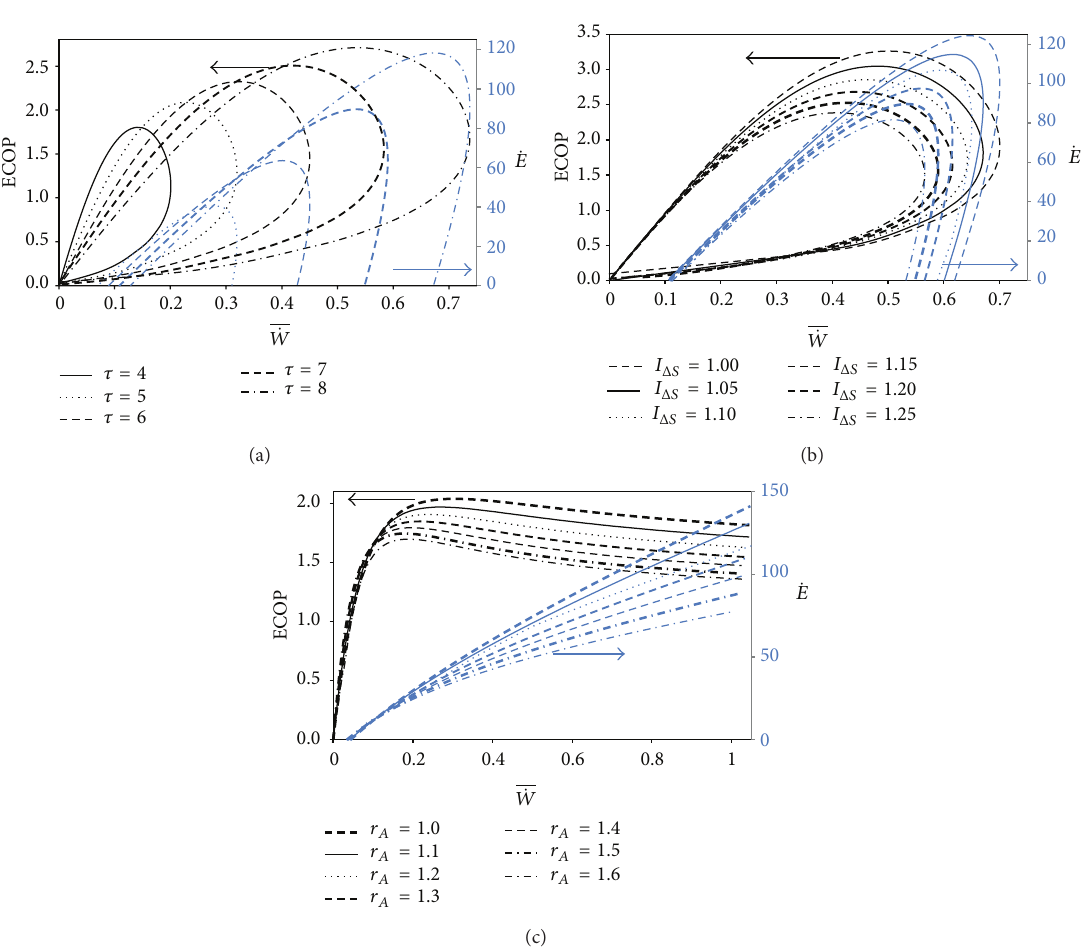
Figure 2: Variations of the ECOP and ecological function with respect to nondimensional power output for (a) various 𝜏 (𝐼 Δ𝑆 = 1.2) ; (b) for various 𝐼 Δ𝑆 (𝜏 = 7) ; (c) for various 𝑟 𝐴 (𝐼 Δ𝑆 = 1.2, 𝛼 = 17) ( 𝑇 0 = 𝑇 𝐿 = 300 K, 𝑋 = (𝑁 𝐻1 + 𝑁 𝐻2 )/𝑁 𝑇 = 0.3 , and 𝜉 = 0.02 ).